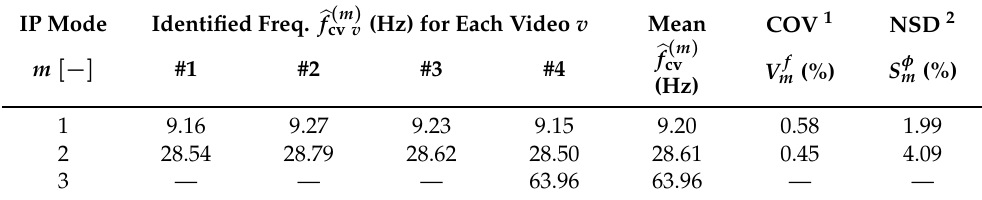
Table 3. Identified modal parameters based on computer vision (smartphone camera).